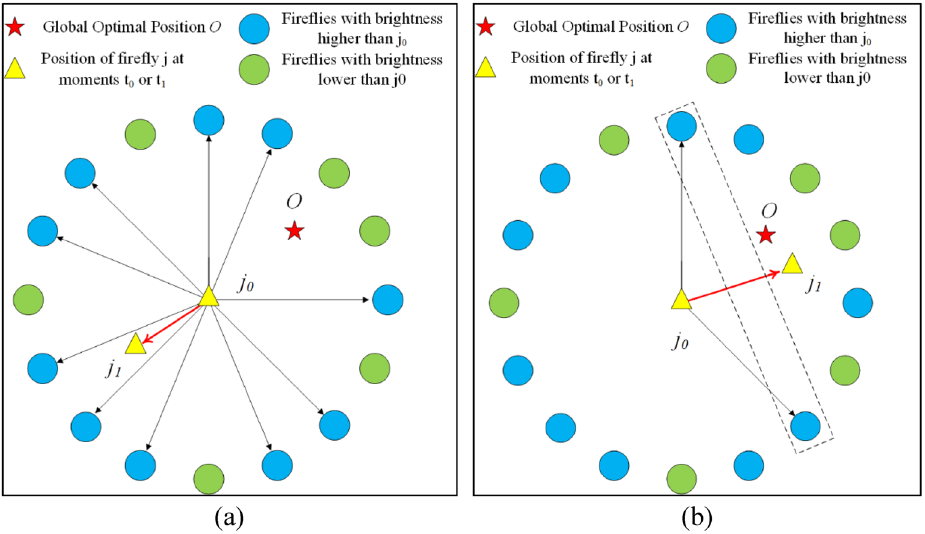
Figure 2. Schematic diagram of full-attraction strategy and partial-attraction strategy: ( a ) full-attraction strategy; ( b ) partial attraction